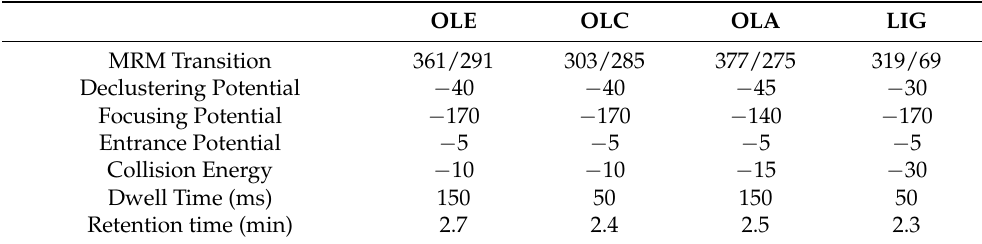
Table 1. Electrospray ionization parameters for the secoiridoids